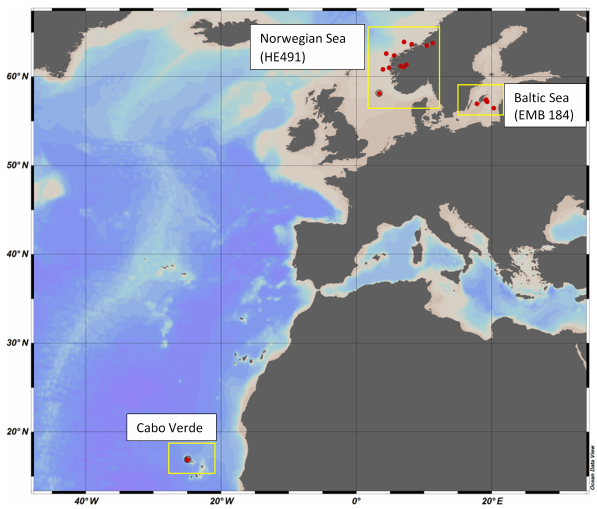
Figure 1. Map showing field campaign areas and